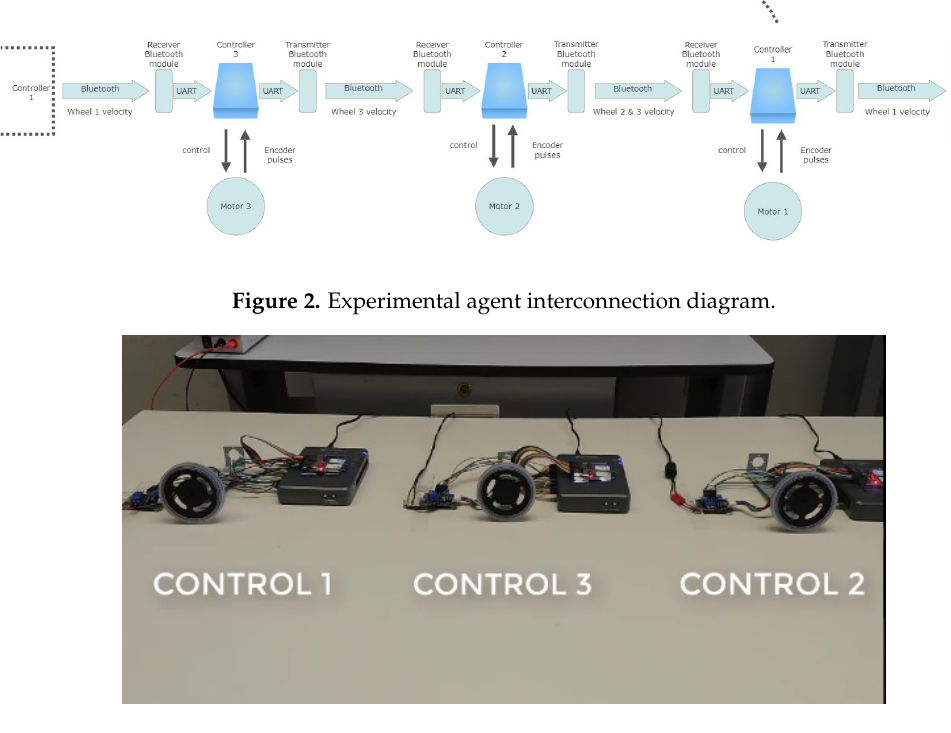
Figure 3. Three-motor synchronization experimental platform. Table 1. Motor parameters and